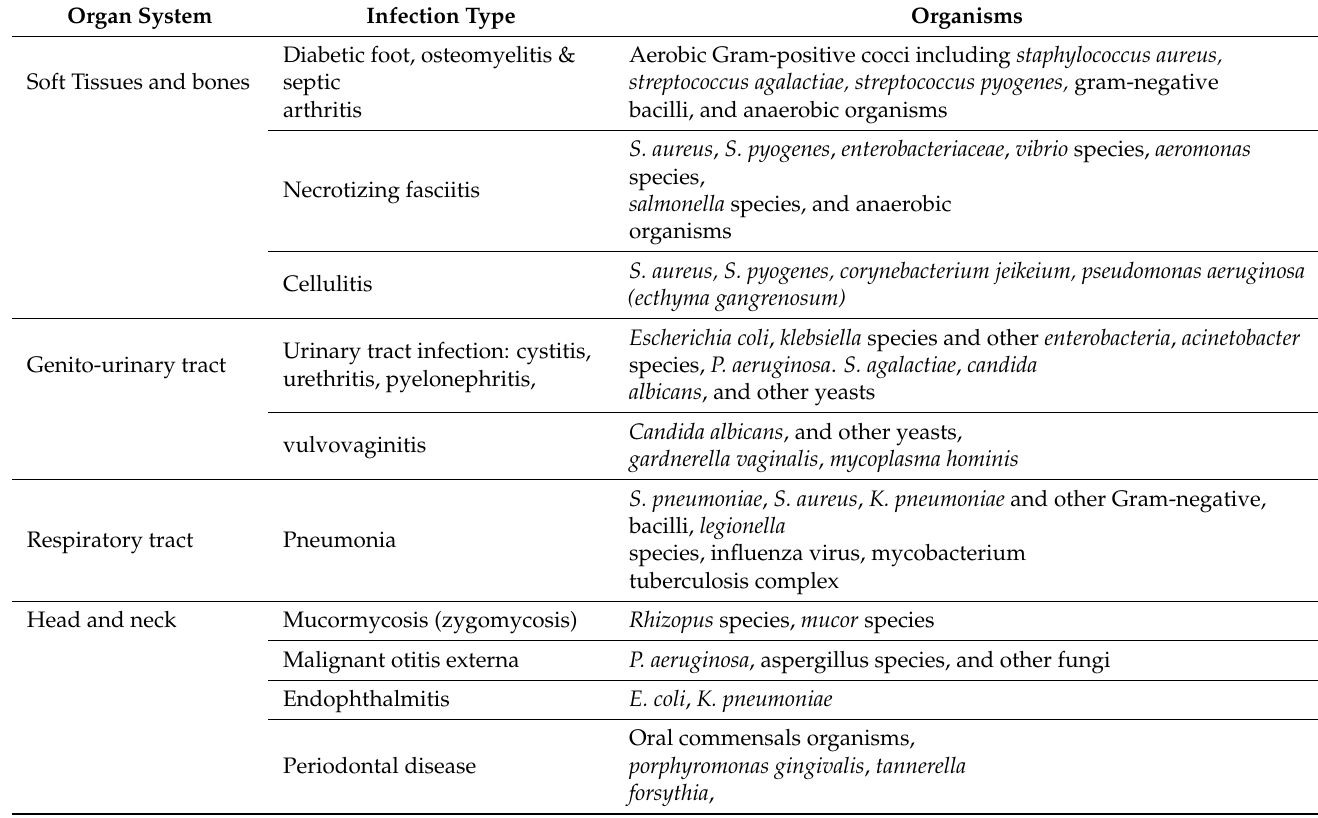
Table 3. List of common infections and their etiologies in patients with